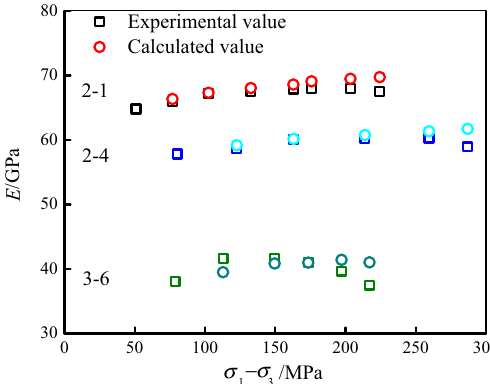
Fig. 10 Elastic modulus experimental values and calculated